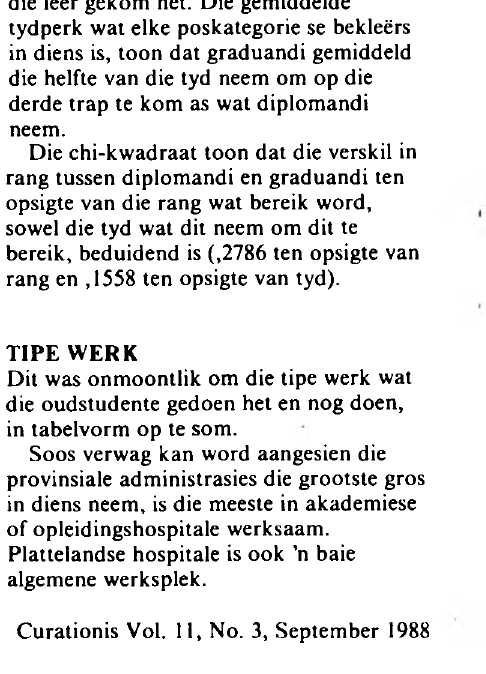
TABEL 5. WERKGEWERS VAN OUDSTUDENTE